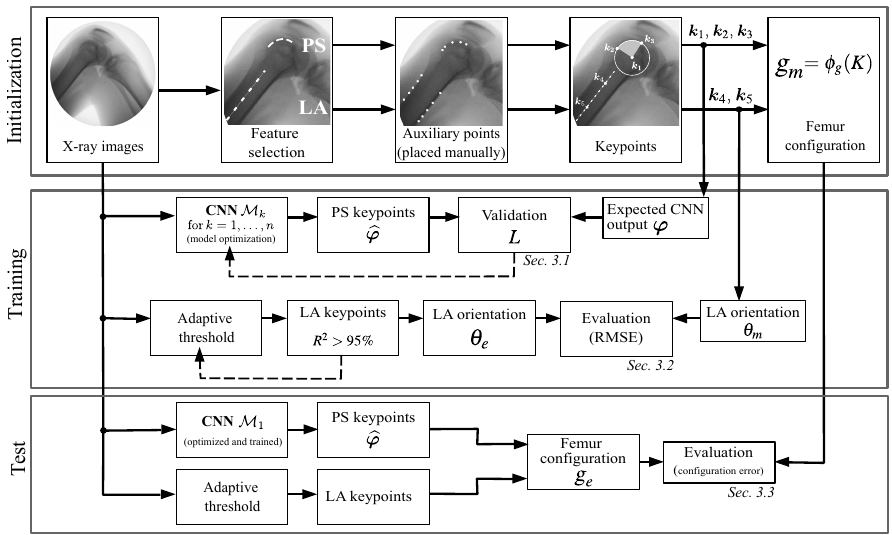
Figure 2. The three stages of the proposed algorithm with schematic representation of each